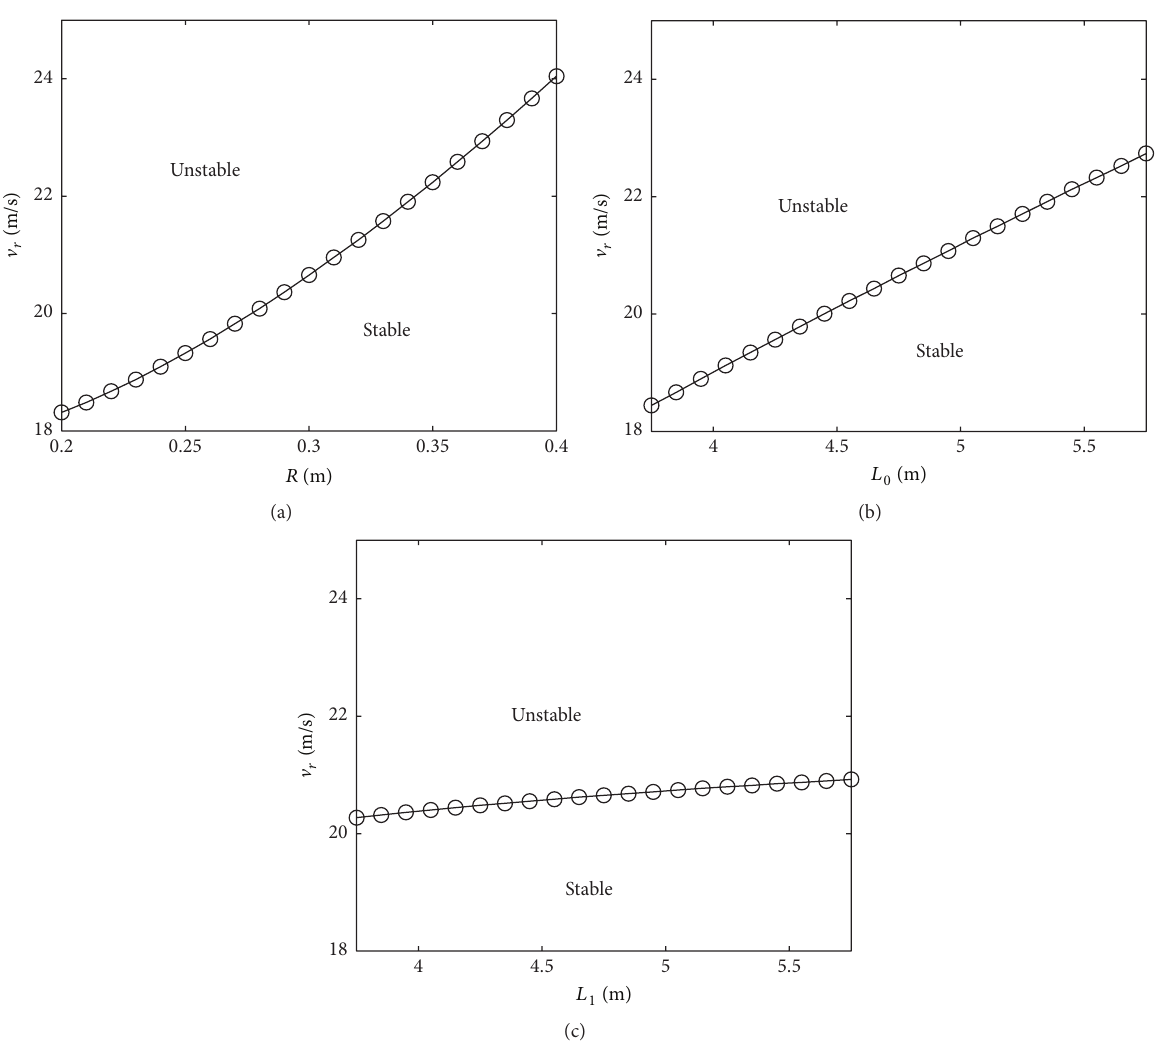
Figure 19: Influences of work roll radius and distances between adjacent stands on system stability. Table 4: Influence of rolling lubricants on system stability.